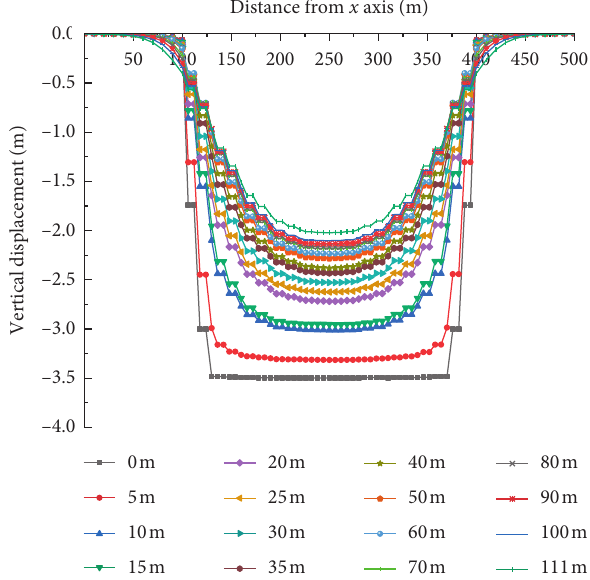
Figure 10: Distribution of vertical displacement on inclination observation